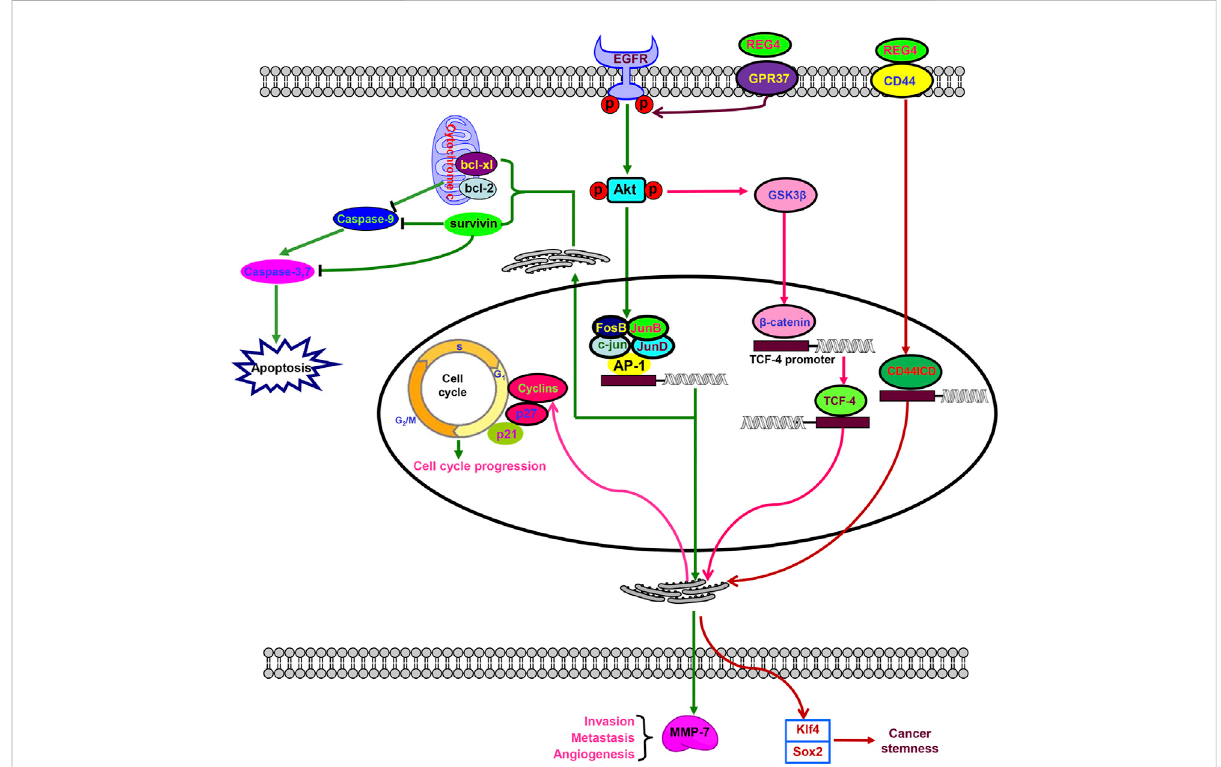
FIGURE 2 Biological functions of REG4. REG4 indirectly interacts with epidermal growth factor receptor (EGFR) to phosphorylate and activate Akt, which induces activator protein-1 (AP-1) – mediated transcriptional initiation by an AP-1/c-Jun/JunA/JunB complex and glycogen synthase kinase three β (GSK3 β ) – β -catenin – transcriptionfactor4(TCF-4)signaling.Additionally,REG4canbindtoGprotein-coupledreceptor37(GPR37)toactivateEGFR. REG4interactswithCD44toactivateregulatedtransmembraneproteolysisofCD44resultingin γ -secretase – mediatedcleavageandreleaseof theCD44intracytoplasmic domain(CD44ICD).TCF-4andCD44ICDserveastranscriptional activatorsthatup-regulatetheexpression ofcyclinsfor cell-cycle progression. CD44ICD-mediated Kruppel-like factor 4 (Klf4) and SRY-box transcription factor 2 (SOX2) expression is involved in cancer stemness. Activator protein-1 – induced overexpression of B cell lymphoma-extra large (Bcl-xL), B cell lymphoma 2 (Bcl-2), survivin, and matrix metalloproteinase-7 (MMP7) plays an important role in apoptosis, angiogenesis, invasion, and